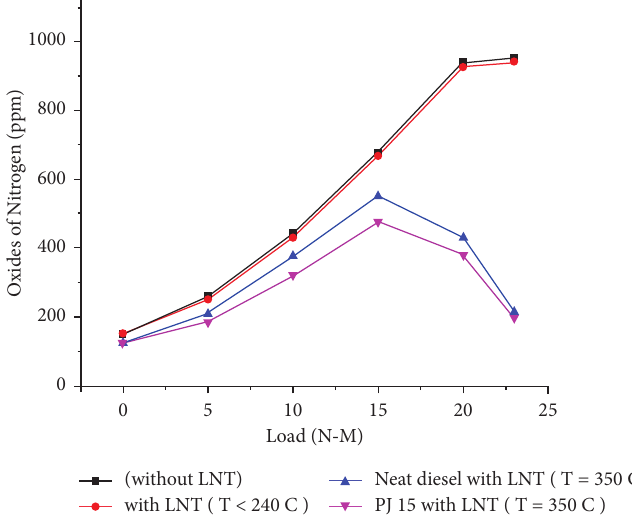
Figure 14: NO x emission curve for Diesel and PJ15 with LNT.